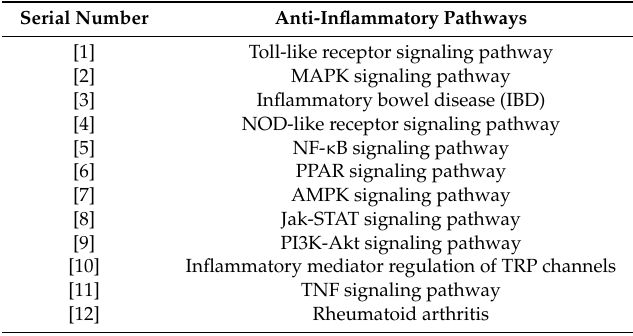
Table 1. Heat map showing various anti-inflammatory